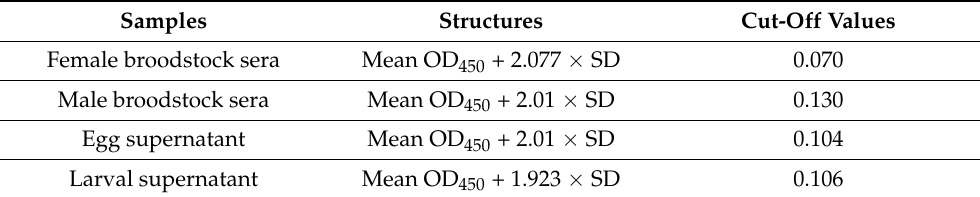
Table 2. Structures for calculation of ELISA cut-off values